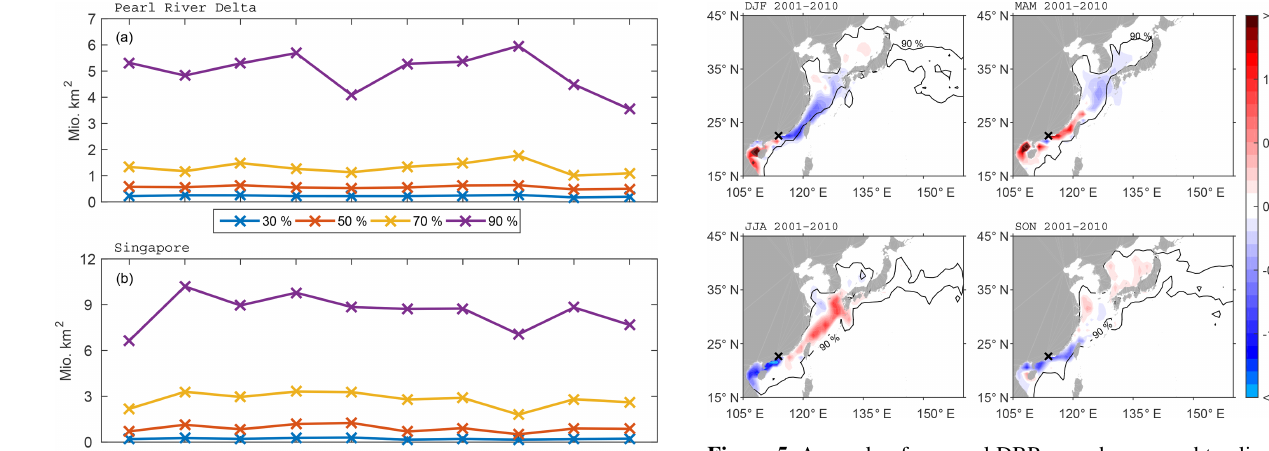
Figure 5. Anomaly of seasonal DBP spread compared to climatol- ogy (2001–2010) at the surface (20m) for discharge in the Pearl River Delta. The black contour line shows the area of the 90% of particles characterised by the highest density in the seasonal mean.